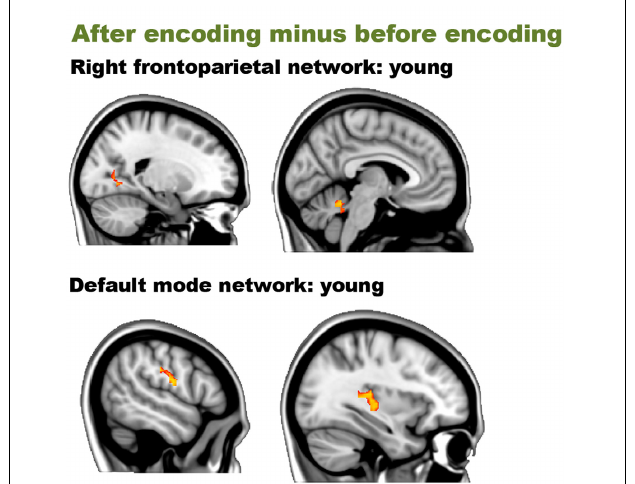
FIGURE 3 | Resting-state differences over time within young participations for the whole brain. Whole-brain within-group effects were found for the contrast “after encoding minus before encoding” in young individuals. Red clusters indicate increased connectivity over time.